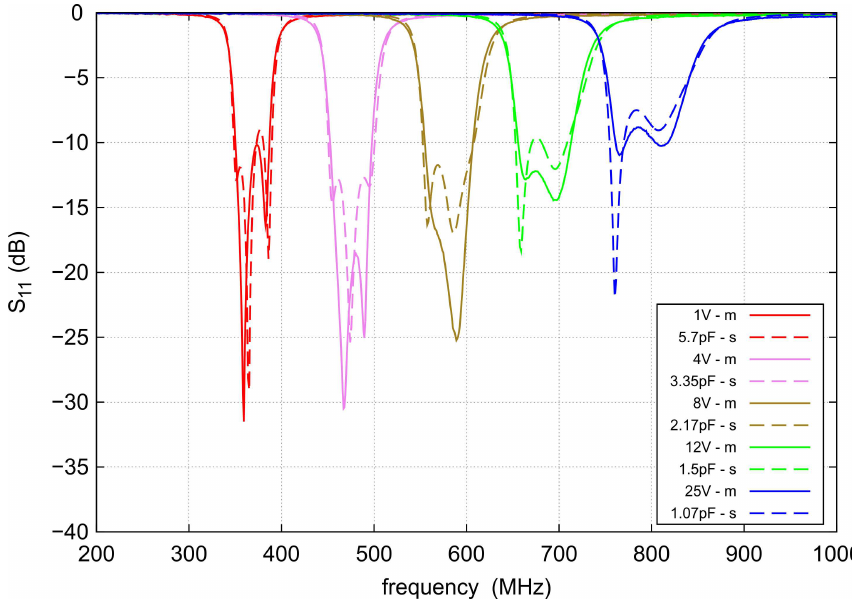
Figure 14. Measured (solid lines) and simulated (dashed lines) s 11 of the proposed tunable bandpass filter for the five selected control